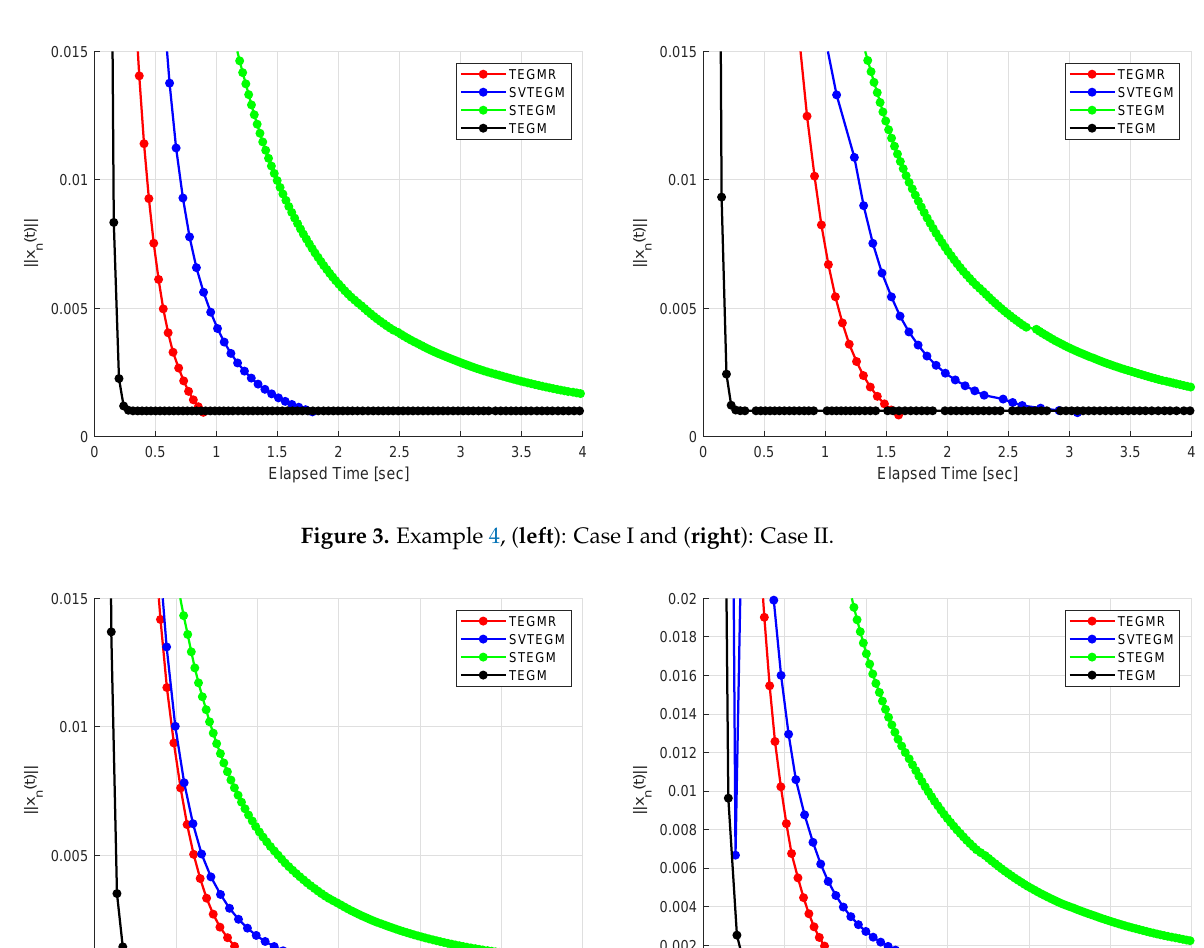
Figure 2. Example 3, ( left ): Case III and ( right ): Case IV.